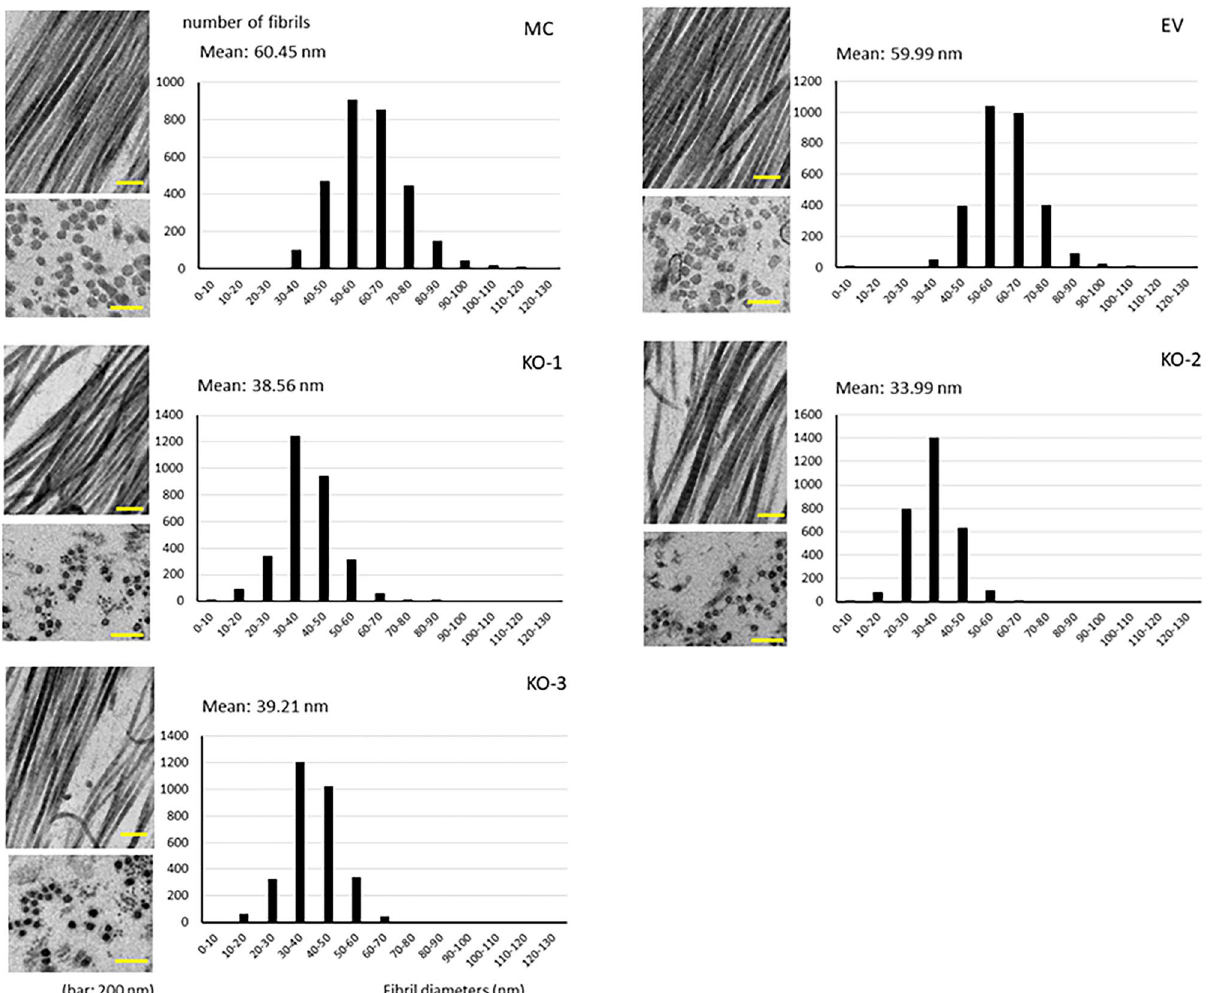
Figure 5. Ultrastructural analysis of collagen fibrils in cell cultures by transmission electron microscopy. The cross-sectional and longitudinal views of the collagen fibrils from MC, EV, and KO. KO collagen fibrils are markedly smaller in diameter. Scale bar represents 200 nm. Diameter distribution measured from cross- sections. Three thousand fibrils in each group were measured from a single experiment and plotted. MC MC3T3-E1, EV empty vector, KO